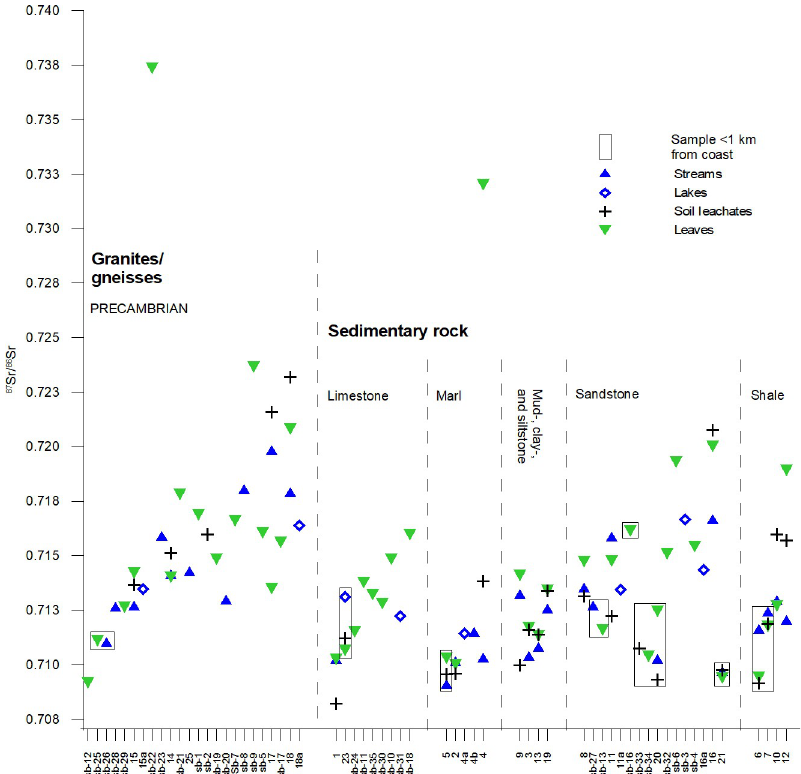
Fig 5. Lithology-based grouping of strontium isotope ratios ( 87 Sr/ 86 Sr) of samples. Sites are grouped according to the lithology of the underlying bedrock at the sampling site. Groups are not spatially coherent. Within each group, sampling sites are sorted with increasing latitude from left to right. Sampling sites located within 1 km of the nearest coast are indicated by a rectangle. Analytical errors, as specified in Table 2, are within individual markers.